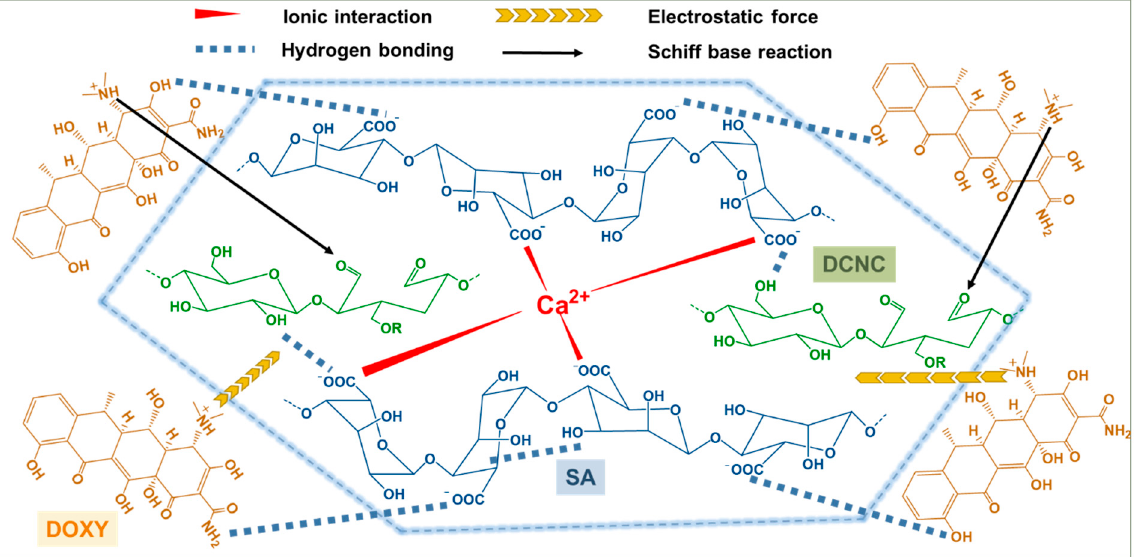
Figure 13. Schematic illustration of various proposed adsorption mechanisms between DOXY and SA–DCNC composite hydrogel beads.